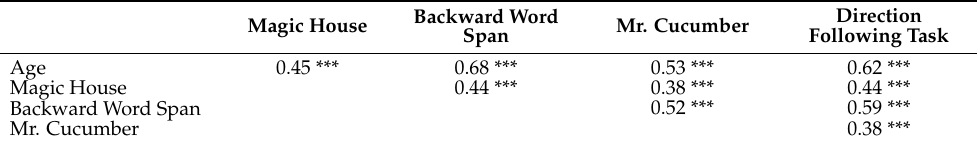
Table 2. Correlations between age, updating, and M capacity tasks.